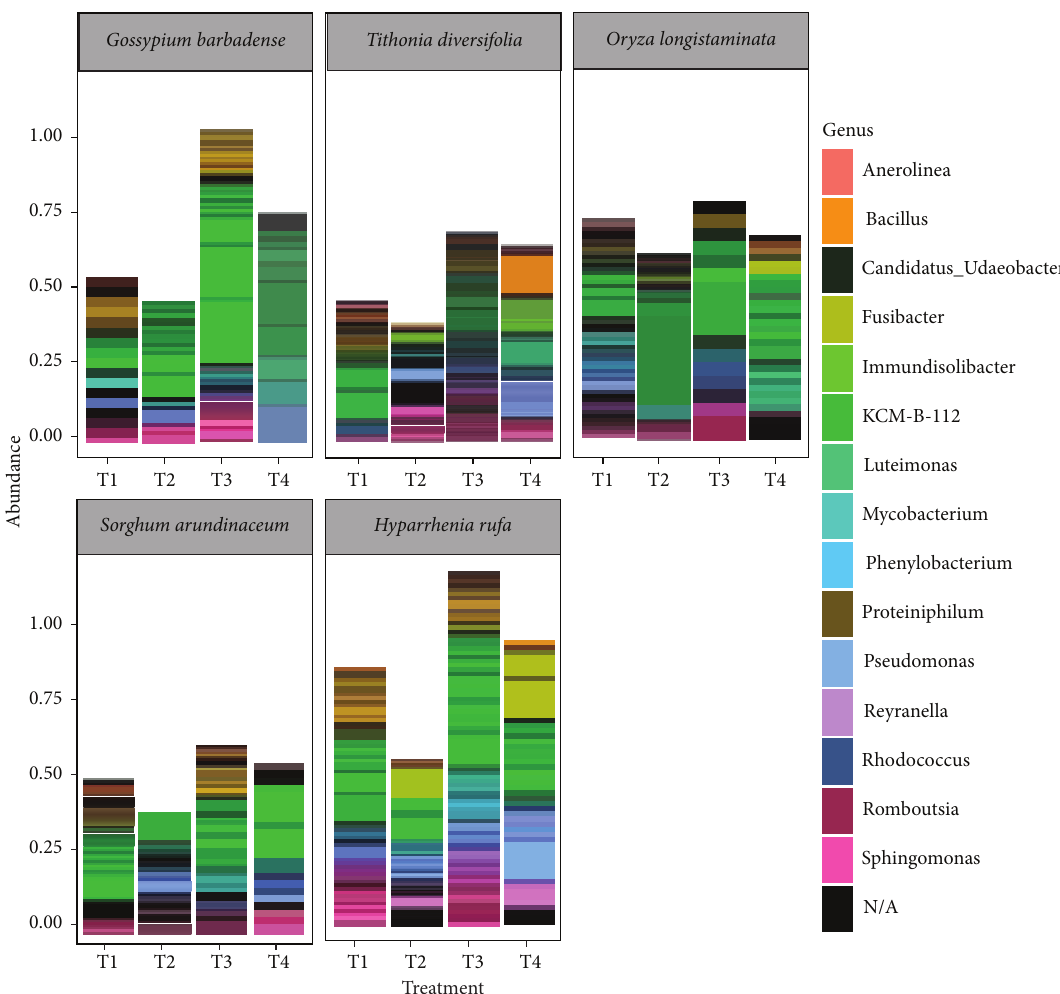
Figure 3: Variation in bacterial genera within rhizosphere of five phytoremediation species under four different treatments (T1 � plant species only, T2 � plant species and hydrocarbon, T3 � plant species and manure, and T4 � plant species, manure, and